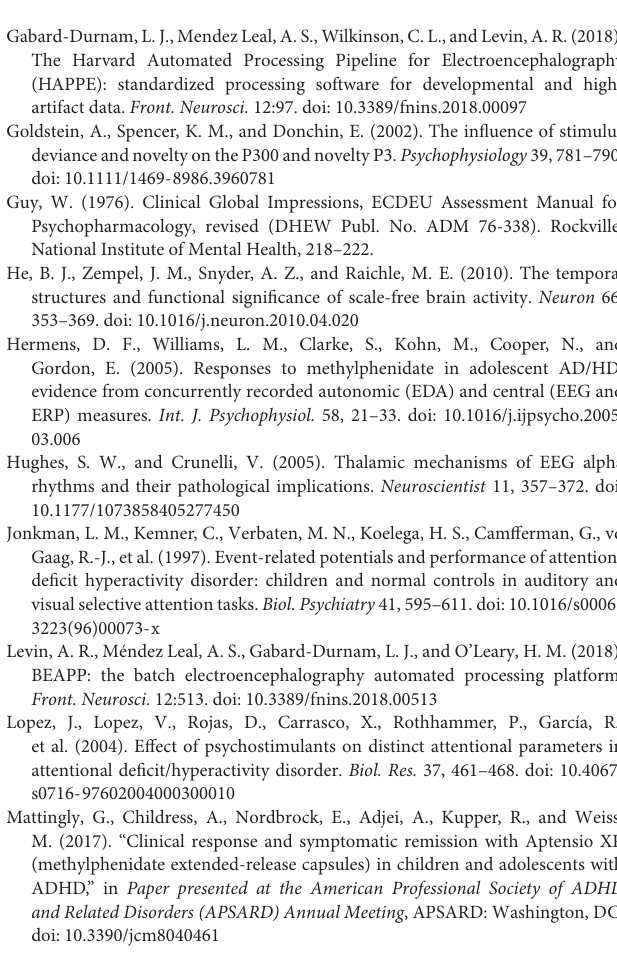
Supplementary Figure 1 | Schematic of the ERP task. Supplementary Figure 2 | ERP waveform for standard, deviant and novel visual oddball